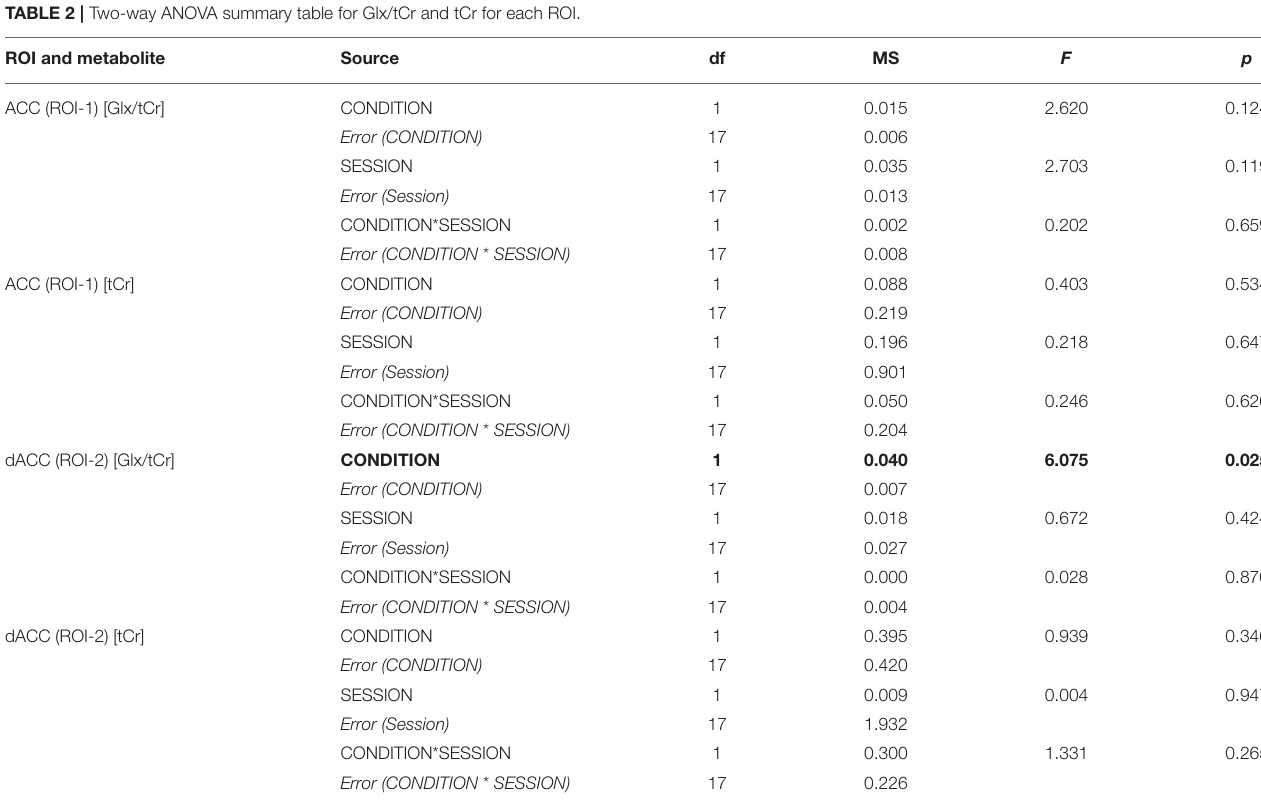
TABLE 2 | Two-way ANOVA summary table for Glx/tCr and tCr for each ROI. ROI and